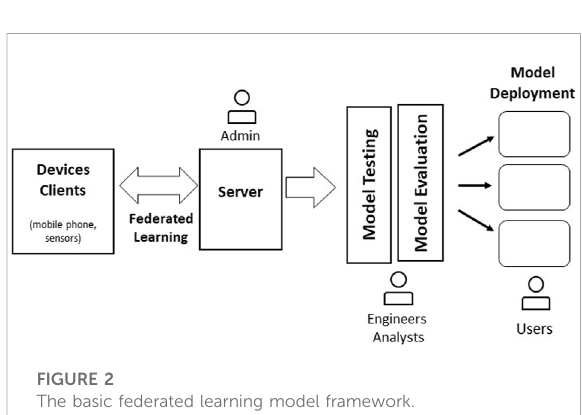
FIGURE 2 The basic federated learning model